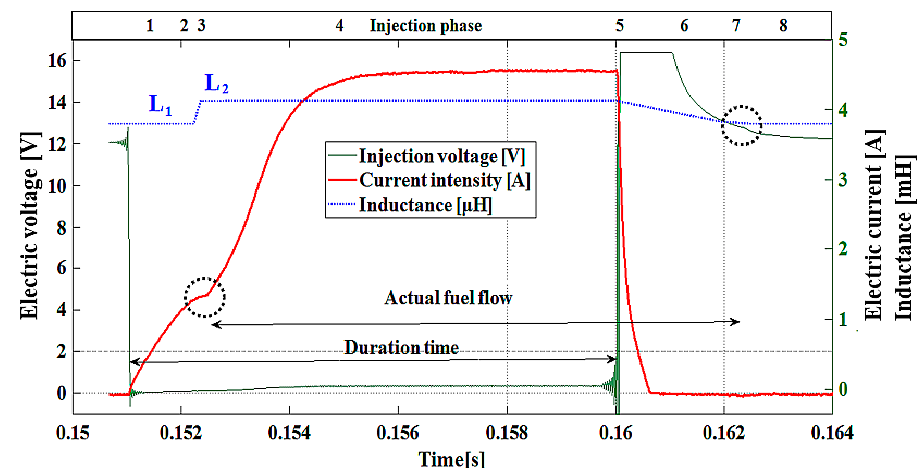
Figure 4. Recorded time-related waveform of injector current–voltage.